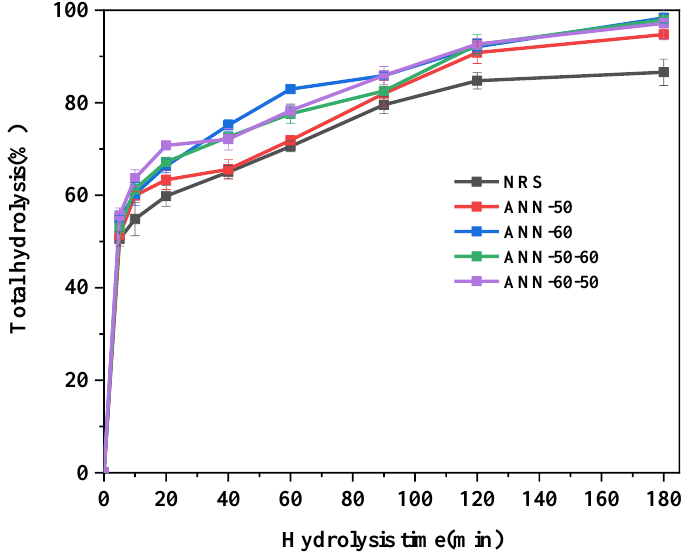
Table 4. The amount of RDS, SDS, and RS of the one and two-step annealed rice starch samples.